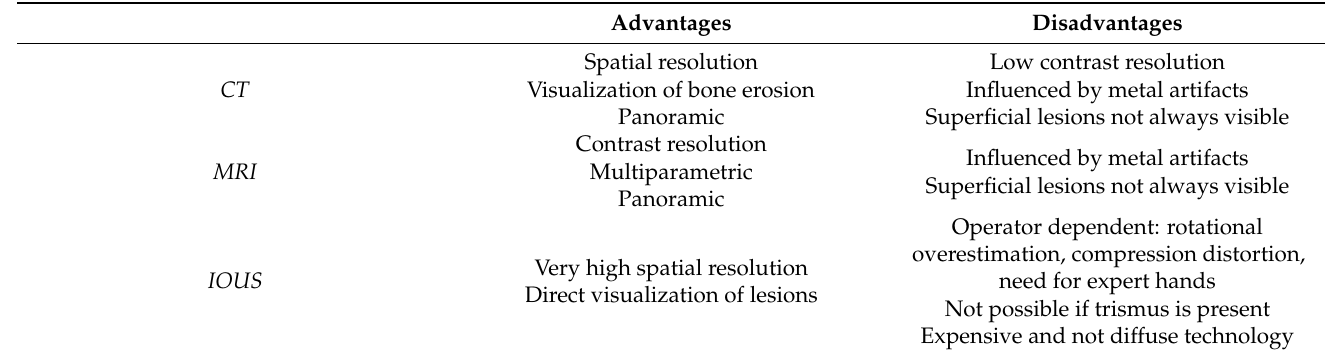
Table 1. Advantages and disadvantages of computed tomography (CT), magnetic resonance imaging (MRI), and intraoral ultrasound (IOUS) in oral cancer local and regional